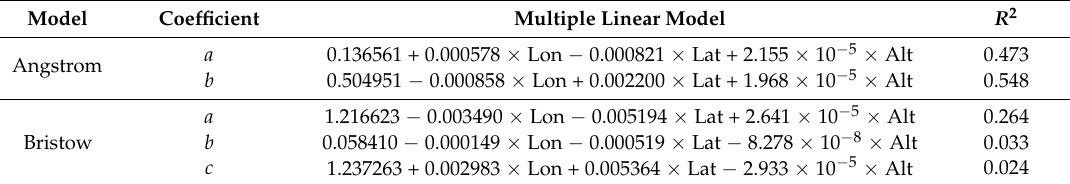
Table 4. Coefficient estimation for the Angstrom- and Bristow-type geographical models.